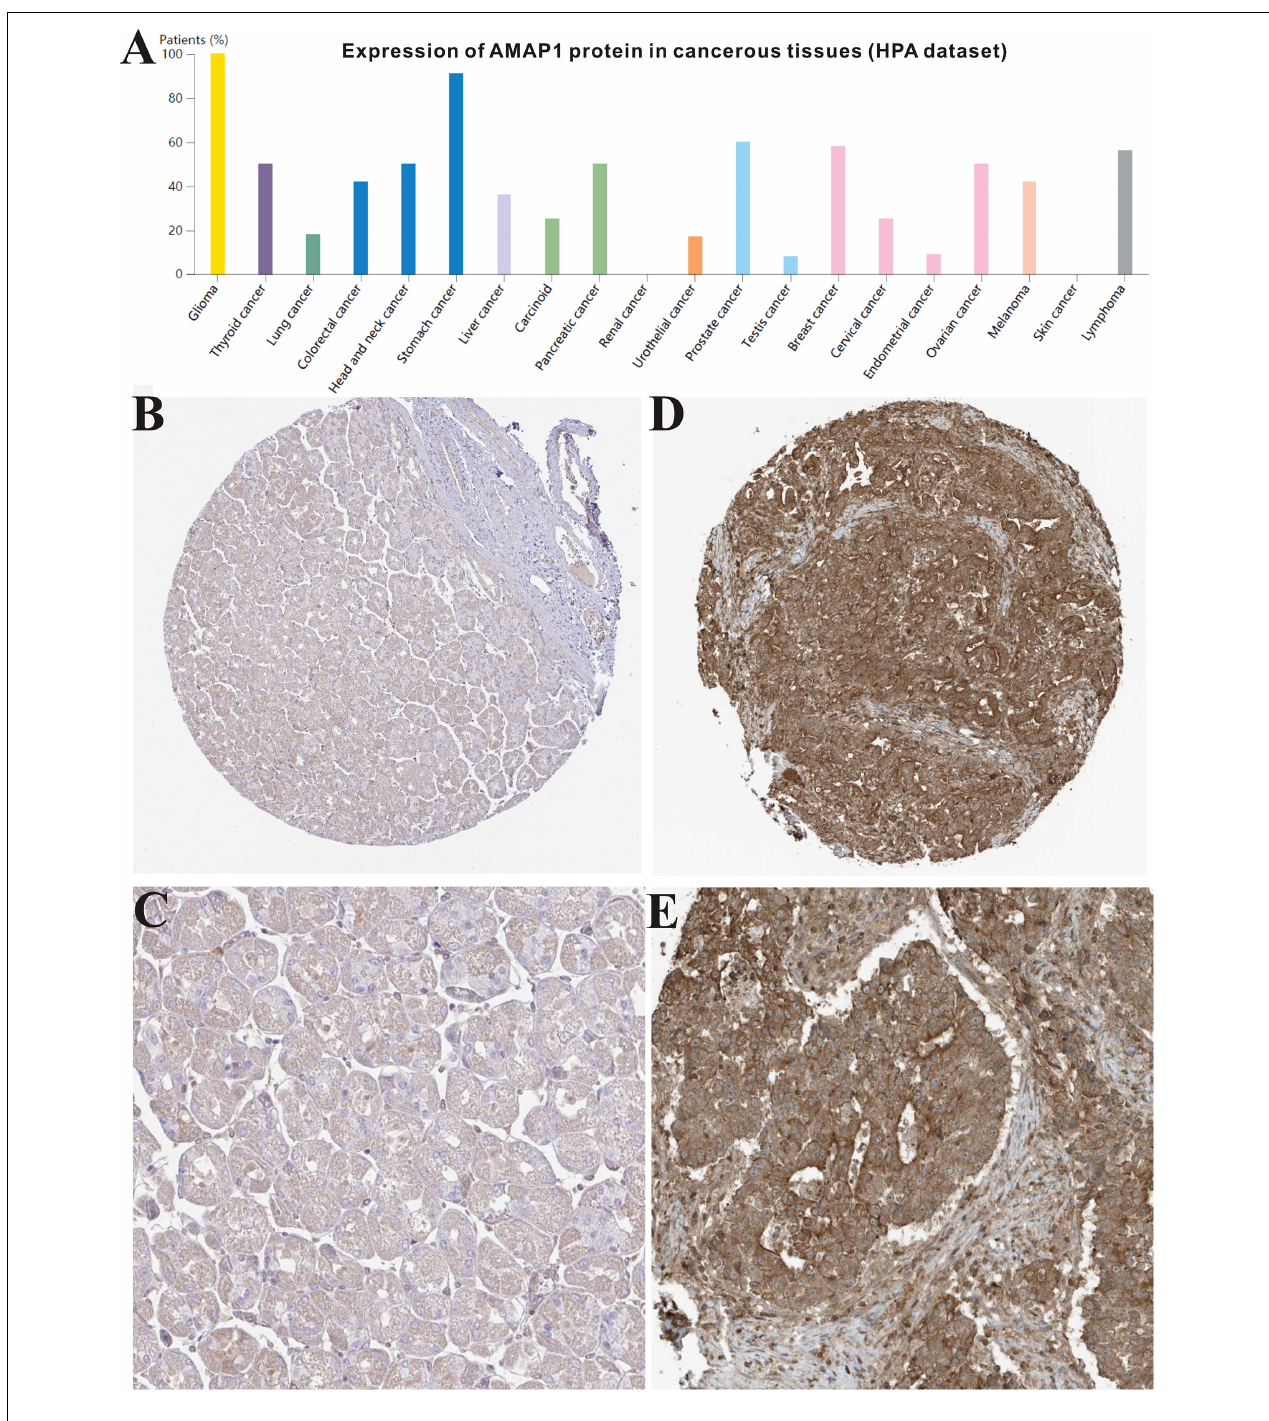
FIGURE 5 | Expression of AMAP1 protein in cancer tissues. The differential expression of AMAP1 protein in various cancers (A) . Representative immunohistochemistry figures of AMAP1 protein in normal stomach specimens (B,C) and in GC tissues (D,E) .